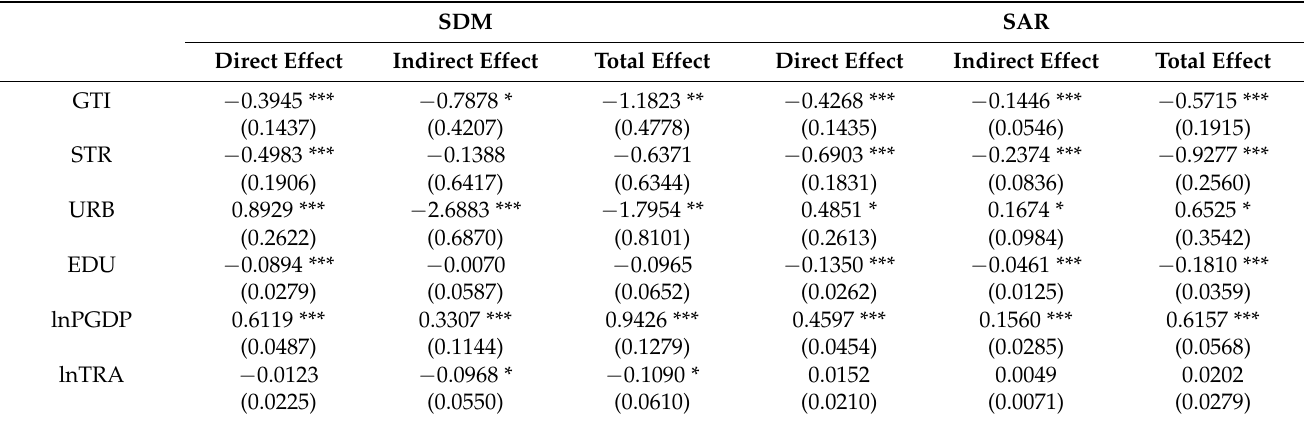
Table 6. Spatial effect decomposition under SDM model and SAR